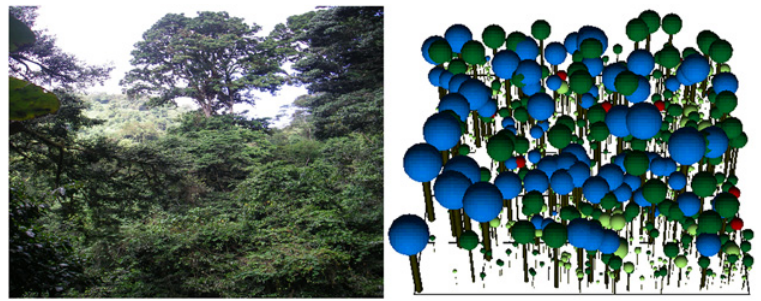
Fig 1. The study site. Left: Photograph of the study site at Mt. Kilimanjaro (FLM3). Right: Visualization of the forest simulated with FORMIND, showing all trees with a stem diameter > 5 cm for a forest area of 1 ha. The colors of the crowns represent the six plant functional types